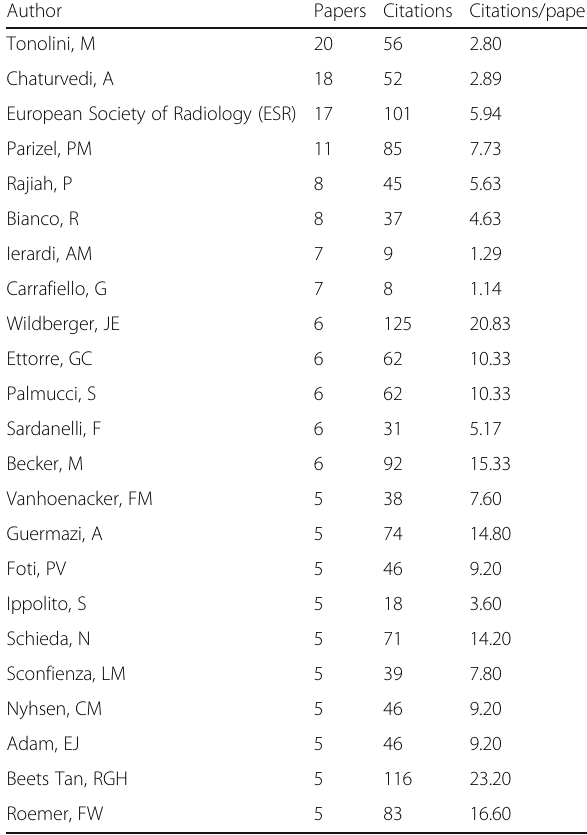
Table 1 Most productive authors ( n > 4 papers)